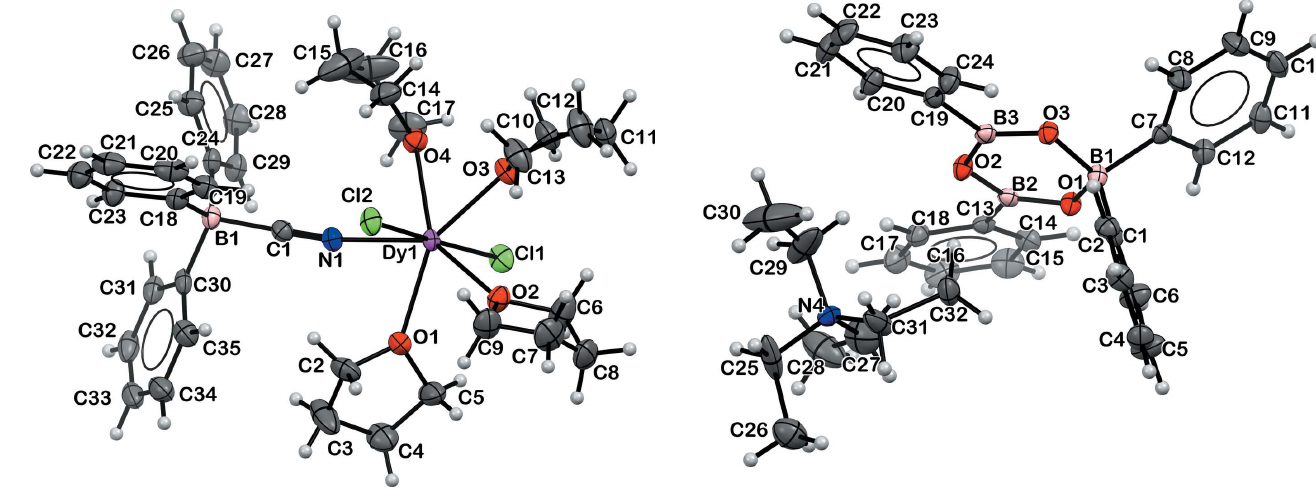
Figure 1 Displacement ellipsoid plot of DyCl 2 (THF) 4 (NCBPh 3 ), 1-Dy , drawn at the 30% probability level.